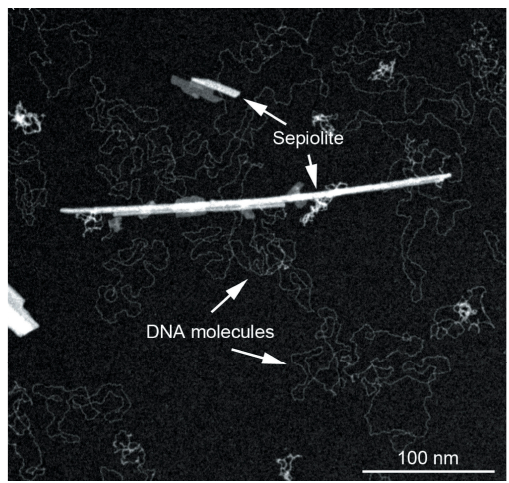
Figure 5. TEM image showing the strong interaction between sepiolite fibers and DNA molecules. Adapted from [74].